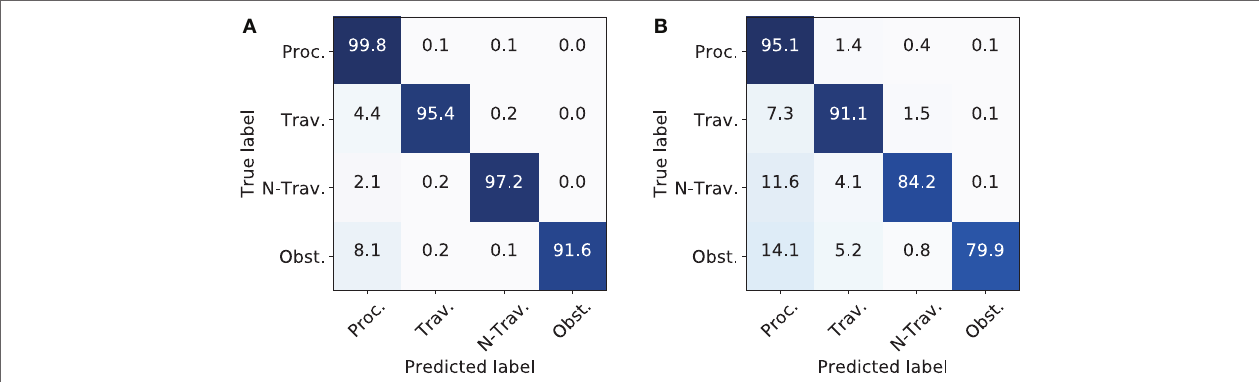
FIGURE 11 | Results for decoding the corresponding classes along the trajectory at close and far range. (A) Confusion matrix for near field. (B) Confusion matrix for far field.